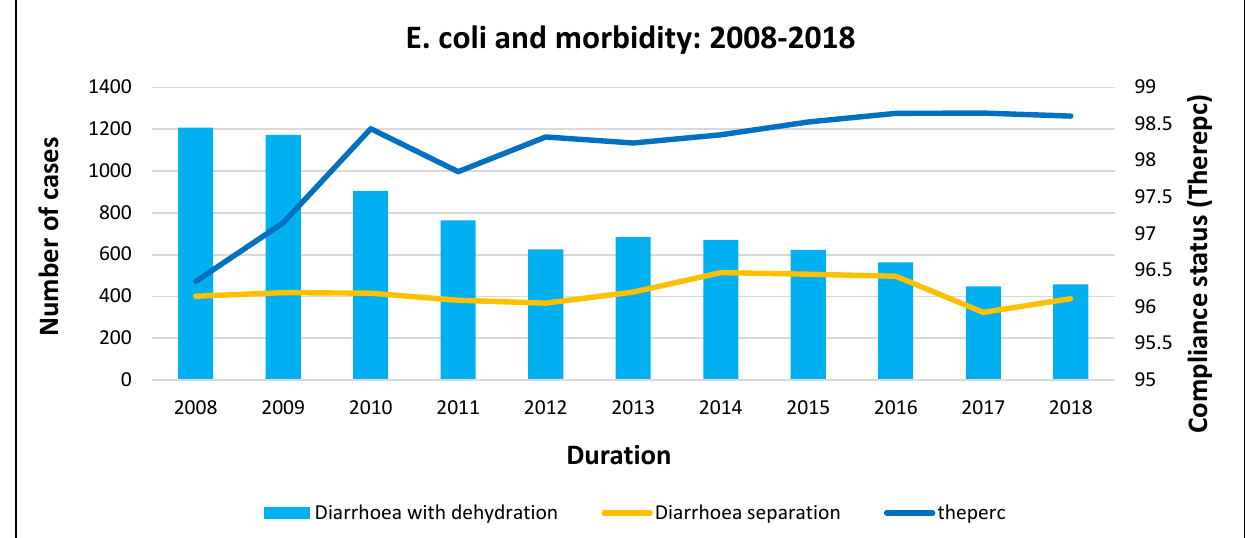
Figure 7. E. coli and morbidity trends at the national level. Total coliforms are defined as a group of aerobic microorganisms and facultatively anaerobic Gram-negative bacteria that have the ability to ferment lactose and are known to be found in the large intestines of humans and animals [1,2]. Total coliforms are listed as indicator organisms for drinking water quality measured in count per 100 mL, and the standard limit is ≤ 10